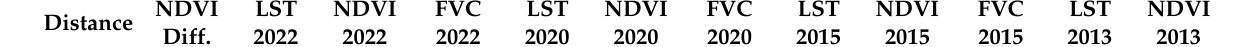
Table 5. The results of correlation calculations between distance from the study area, difference in normalized difference vegetation index (NDVI Diff.) between 2013 and 2022, land surface temperature (LST), NDVI, and fractional vegetation cover (FVC) for 2022, 2020, 2015 and 2013 (highlights significance: red: ≥ 60% and significant, yellow: ≤− 60% and significant, and grey: ± 50% and almost significant). NDVI LST NDVI FVC Distance Diff. 2022 2022 2022